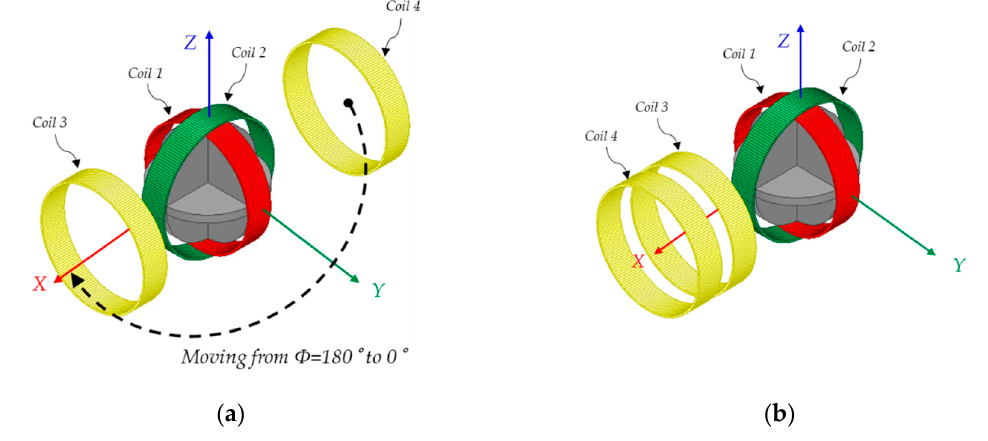
Figure 6. Situations where mutual inductance between receivers increases: ( a ) Position of coil 3 is ( D = 150 mm, θ = 90 ◦ , φ = 0 ◦ ), and position of coil 4 is ( D = 200 mm, θ = 90 ◦ , φ = 180 ◦ ); ( b ) position of coil 3 is ( D = 150 mm, θ = 90 ◦ , φ = 0 ◦ ), and position of coil 4 is ( D = 200 mm, θ = 90 ◦ , φ = 0 ◦